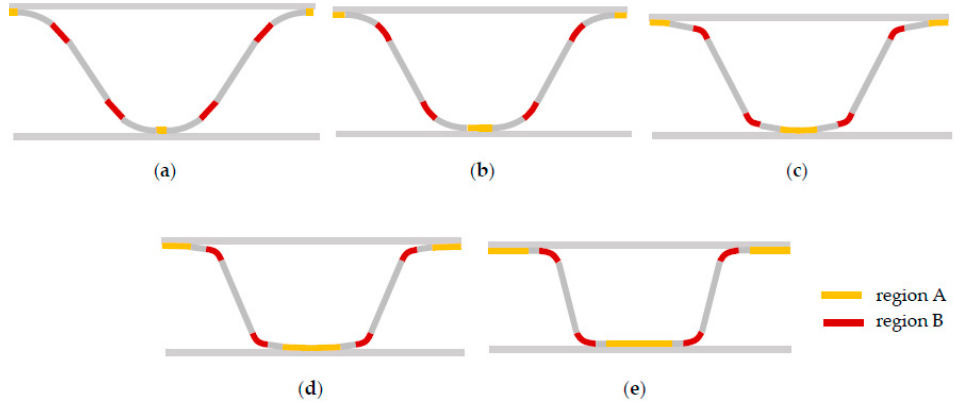
Figure 9. A and B regions for all geometries of corrugated cardboard considered, i.e., with crushing of ( a ) 10% , ( b ) 20% , ( c ) 30% , ( d ) 40% and ( e ) 50%